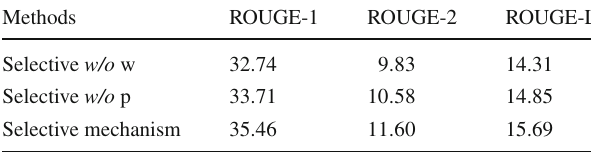
Table 1 Results of selective mechanism and its variants on the test set Methods